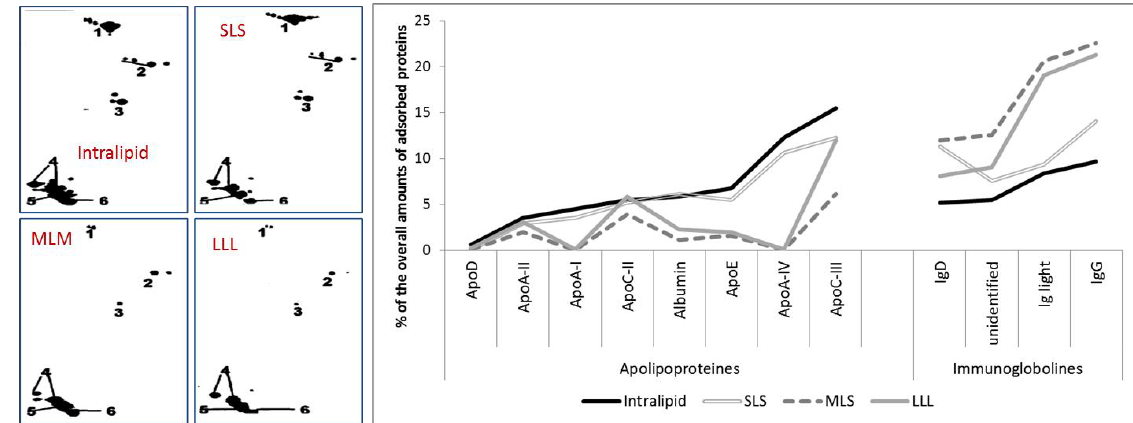
Figure 3. Adsorption of apolipoproteins on 10% Intralipid-, SLS-, MLM- and LLL-emulsions. Left : Close-ups of the bottom left part of the 2-D PAGE gels. Isoelectric point pI 4.4 to 6.0 (from left to right, not linear), molecular weight (MW) 6–46 kDa (from bottom to top, not linear). Protein spot number: (1) ApoA-IV, (2) ApoE, (3) ApoA-I, (4) ApoC-III, (5) ApoC-II, (6) ApoA-II. Right : type and amount of proteins adsorbed onto the different emulsion (modified after